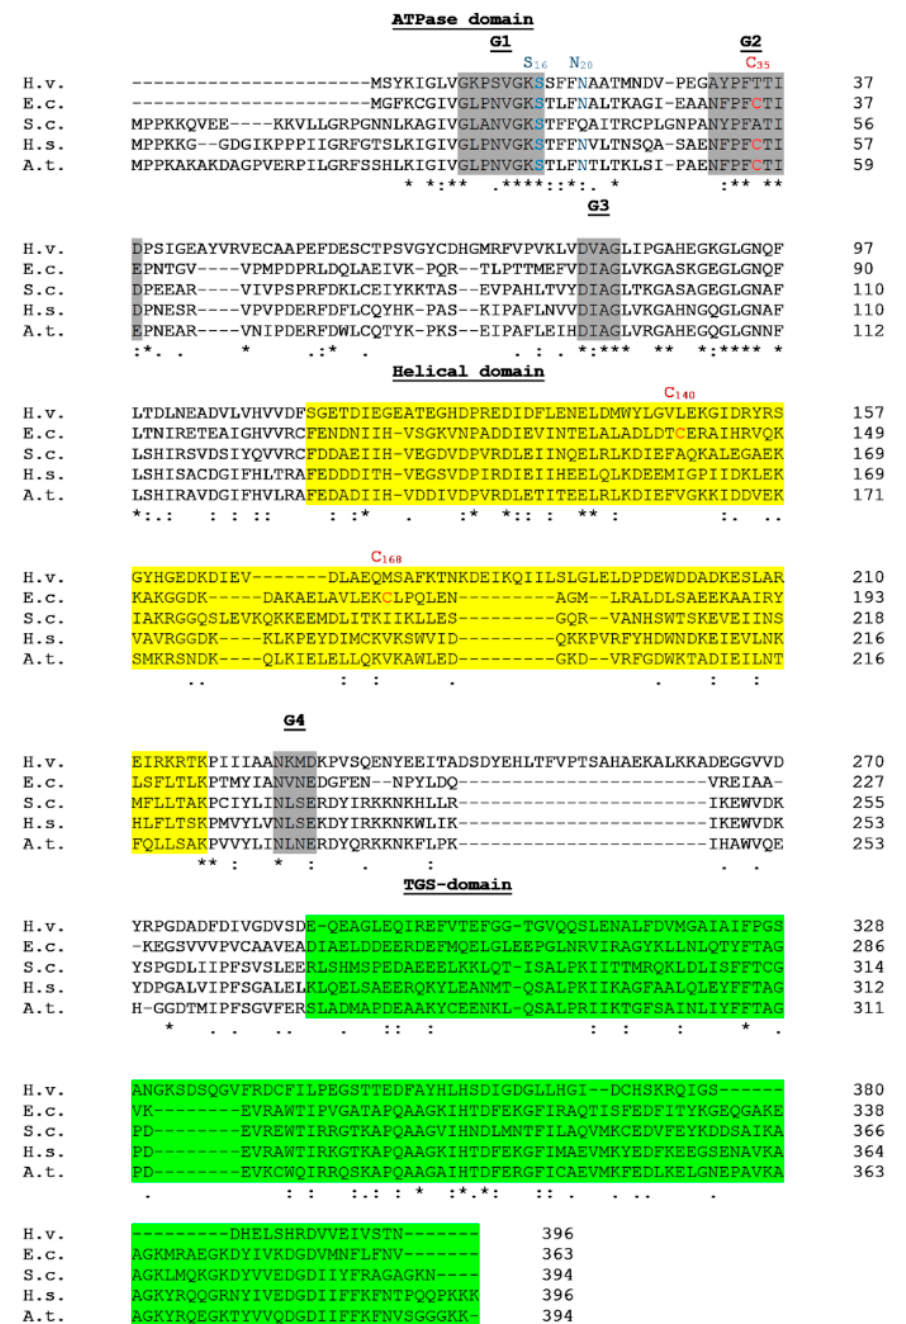
Figure 2. Sequence alignment of YchF/Ola1 from different species. Indicated are the three domains and the G1–G4-motifs, which define nucleotide binding and specificity. In addition, the conserved serine residue (S16 in E. coli ), which was shown to be phosphorylated and the largely conserved cysteine residue (C35 in E. coli ), which forms intermolecular disulphide-bridges, are indicated. YchF in E. coli and many other proteobacteria contains two additional closely spaced cysteine residues (C140 and C168 in E. coli ), which could constitute a redox switch. H.v., Haloferax volcanii ; E.c., was performed with the ClustalW multiple sequence alignment tool. (*) indicates positions which have a single, fully conserved residue; (:) indicates conservation between groups of strongly similar properties (>0.5 in the Gonnet PAM 250 matrix) and (.) indicates conservation between groups of weakly similar properties ( ≤ 0.5 in the Gonnet PAM 250